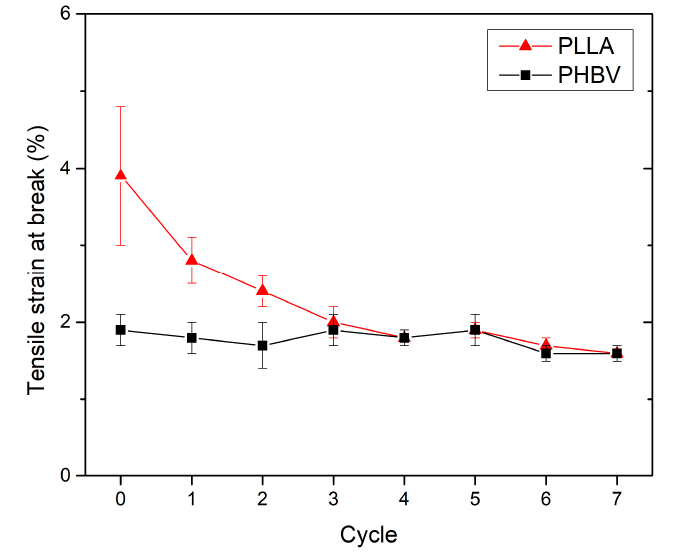
Figure 10. PLLA and PHBV tensile strain at break as a function of recycled cycle.